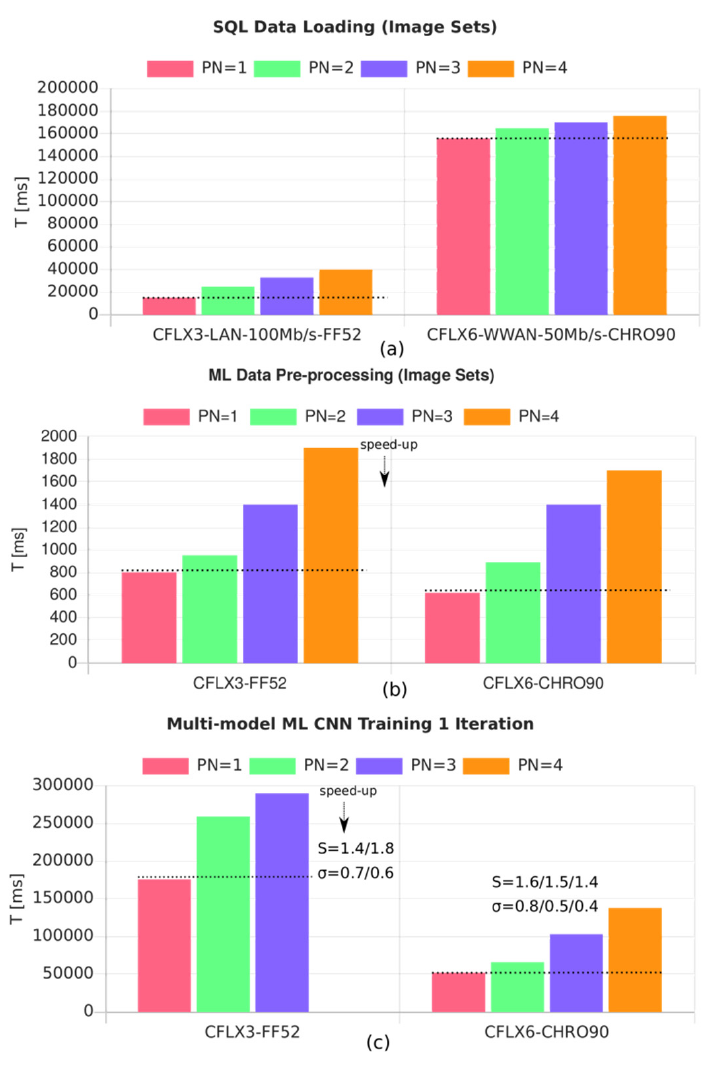
Figure 15. Results of the total computation times, with web worker processing of multi-model CNN-ML tasks with a different number of workers PN. CF-LX3/LX6: NC = 2. ( a ) Input data loading times from SQL data base; ( b ) data pre-processing times; ( c ) training times.